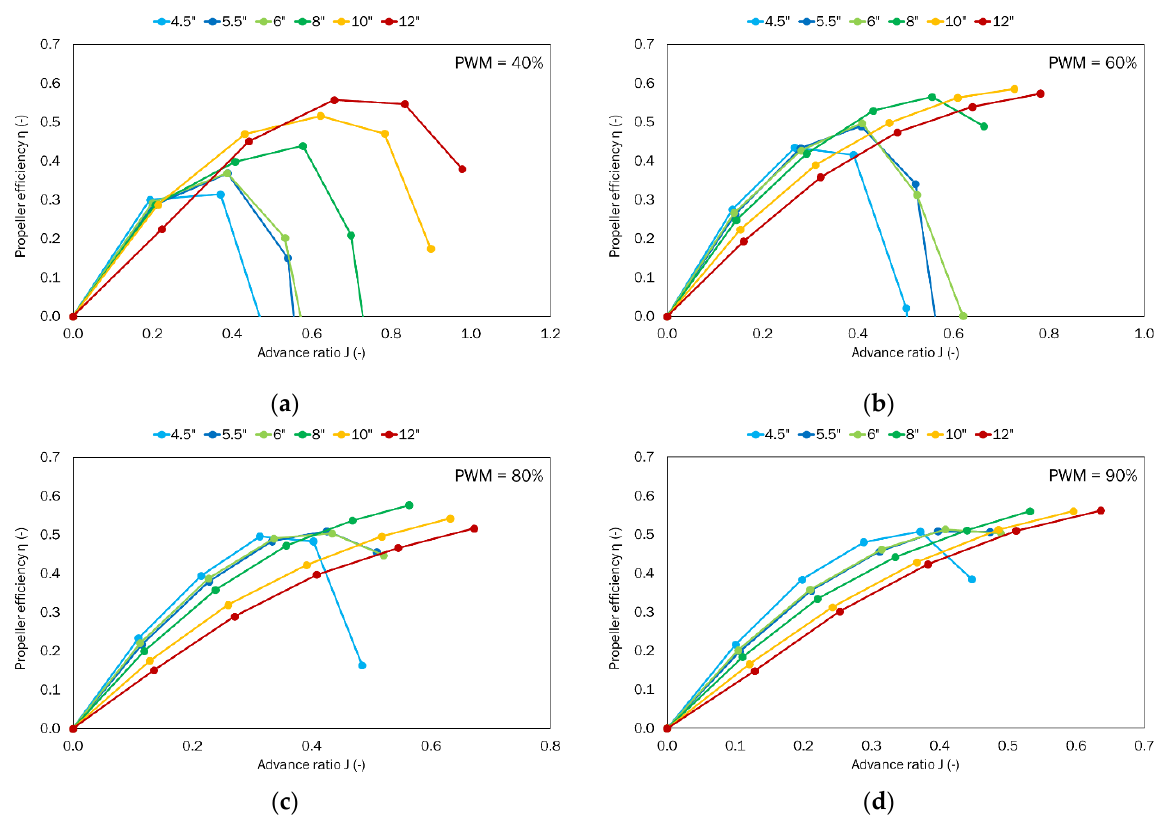
Figure 12. Propeller efficiency as a function of the advance ratio for the tested set of propellers for the defined PWM values: ( a ) 40%; ( b ) 60%; ( c ) 80%; ( d )